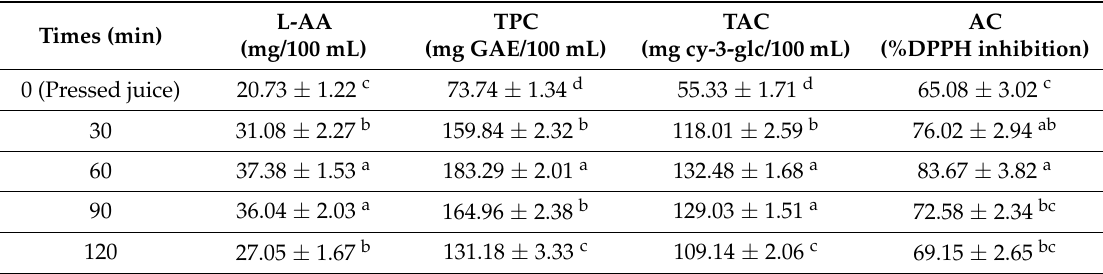
Table 3. L -ascorbic acid, total phenolics, total anthocyanin contents, and antioxidant capacities (mean ± SD) in mulberry juice at different sonicating